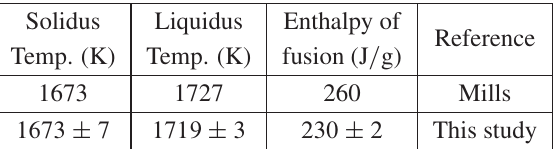
Table 3. Solidus and liquidus temperature and enthalpy of fusion for SUS304.